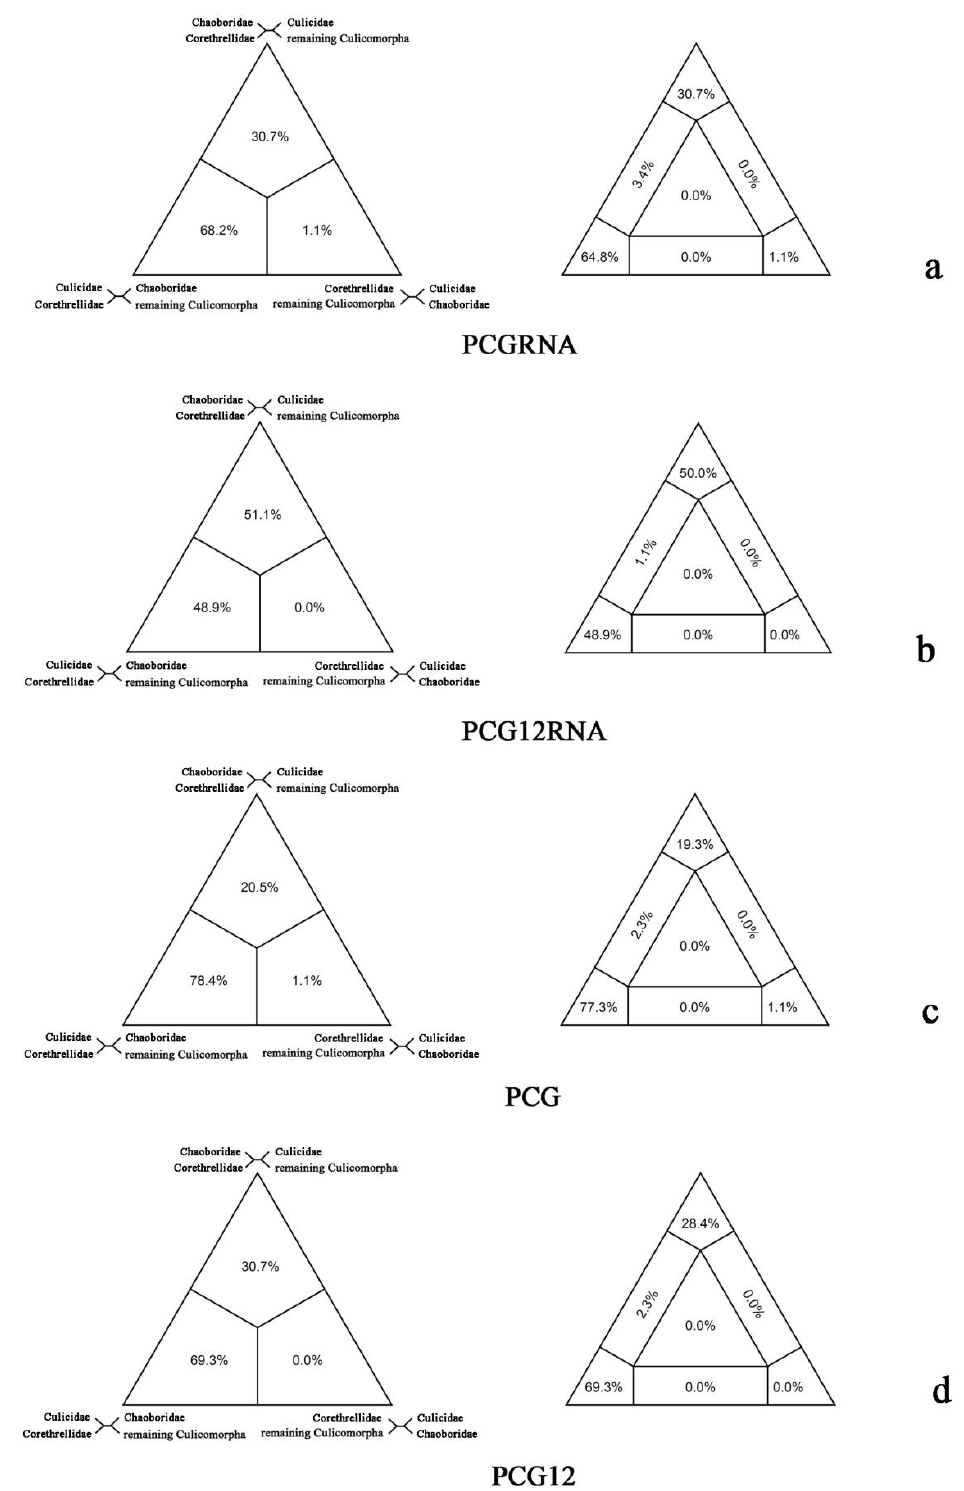
Figure 4. Results of Four-cluster Likelihood Mapping as 2D simplex graphs. ( a ) Four-cluster Likelihood Mapping based on PCGRNA; ( b ) four-cluster Likelihood Mapping based on PCG12RNA; ( c ) four-cluster Likelihood Mapping based on PCG; ( d ) four-cluster Likelihood Mapping based on PCG12.